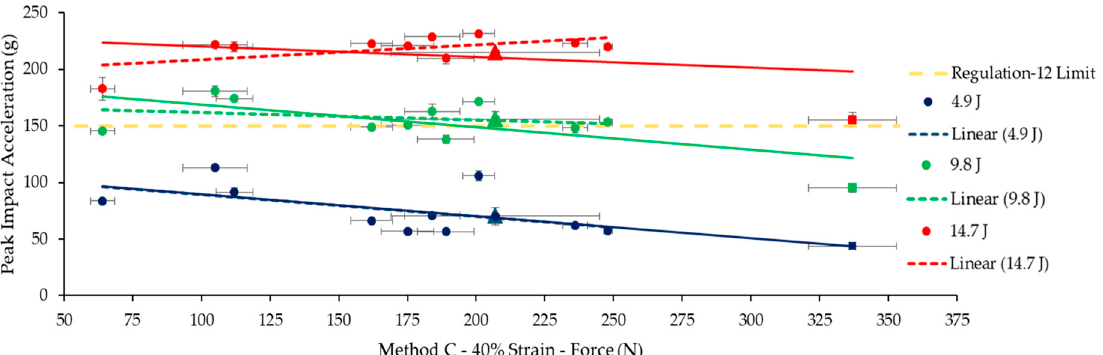
Figure 3. Peak impact acceleration vs. compliance at impact energies of 4.9, 9.8 and 14.7 J. Compliance measured using ISO-2439 Method C. The error bars indicate SD. Sample 10 (with high variance in compliance) is represented by triangles. The linear trend for padding excluding (dashed) and including (continuous) the control material (square) is